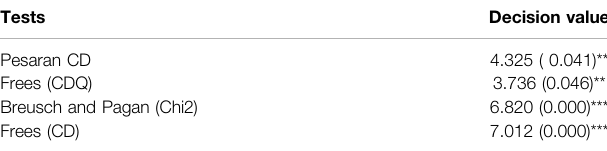
TABLE 5 | Results from the pedroni board Co-integration test.